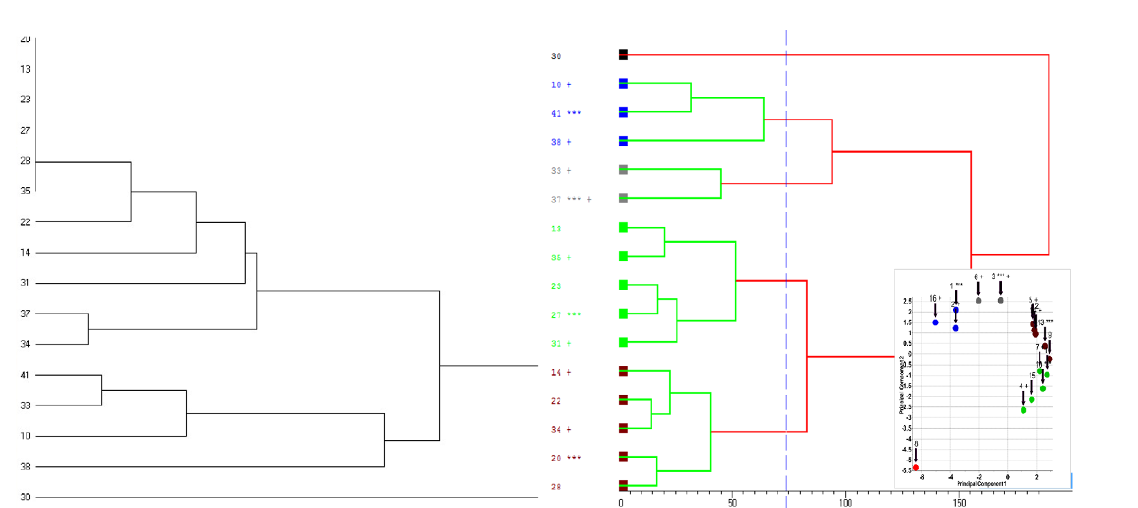
Figure 4. Left: hierarchical cluster analysis dendrogram obtained on the basis of the quantitative phase composition data calculated using PXRD whole-profile approach (4 variables, 16 samples, fursthest neghbour strategy with chord distance). Right: Hierarchical cluster analysis dendrogram obtained on the basis of the whole-profile method (multiple whole-profile variables, 16 samples, and principal component analysis plot (insert)). Table 4. Comparison of calculi grouping based on chemical and PXRD